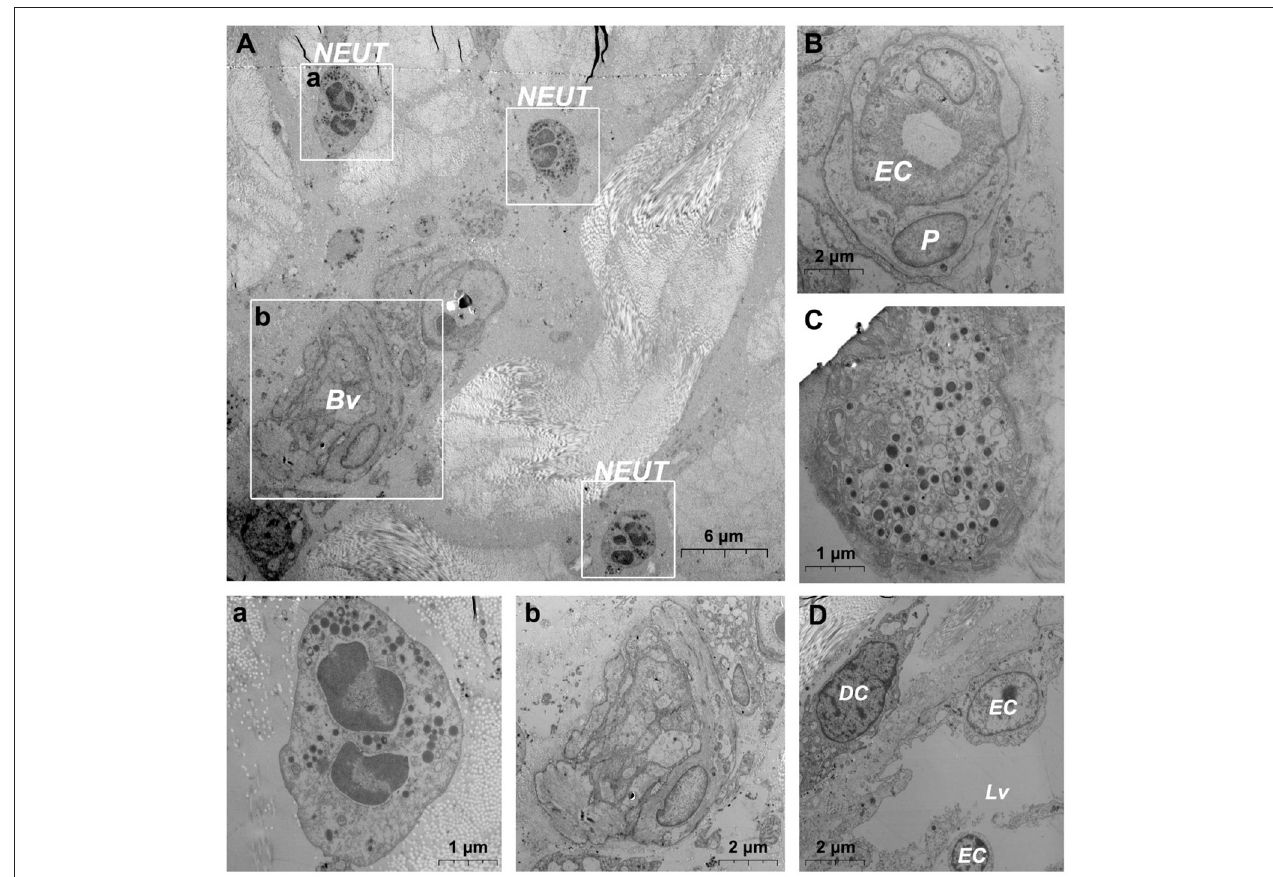
FIGURE 6 | Ultrastructural analysis of the microvessel via TEM after jet needle-free injection. (A) Ultrastructure of the microvessel and surrounding cells after jet needle-free injection; (a) is the enlargement of neutrophils in (A) ; (b) is the enlargement of blood vessels in (A) ; (B) Swollen microvessels after jet needle-free injection; (C) Mast cell that is degranulating after jet needle-free injection. (D) Swollen lymphatic vessel and surrounding dendritic cell after jet needle-free injection . Bv, blood vessel; NEUT, neutrophil; DC, dendritic cell; Lv, lymphatic vessel. The scale bar (A) = 6 µ m; (B,D) (b) = 2 µ m; (C) (a) = 1 µ